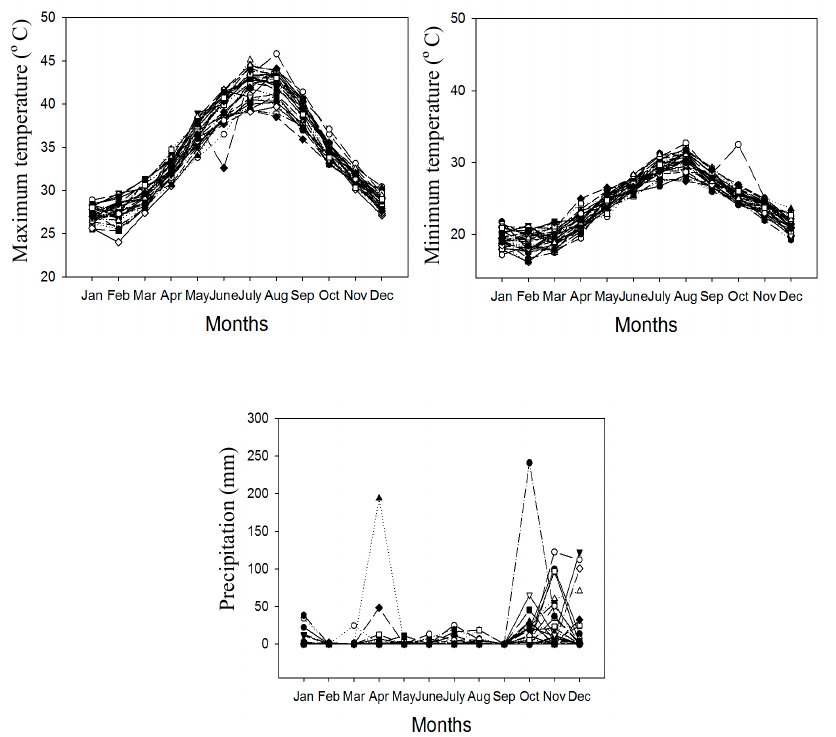
Figure 2. Monthly profile of maximum temperature, minimum temperature and precipitation from 1985 to 2015.